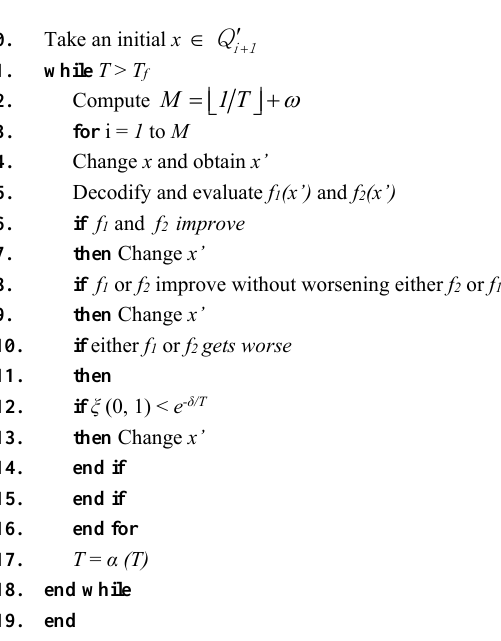
Fig. 2. Pseudo-code of the Simulated Annealing